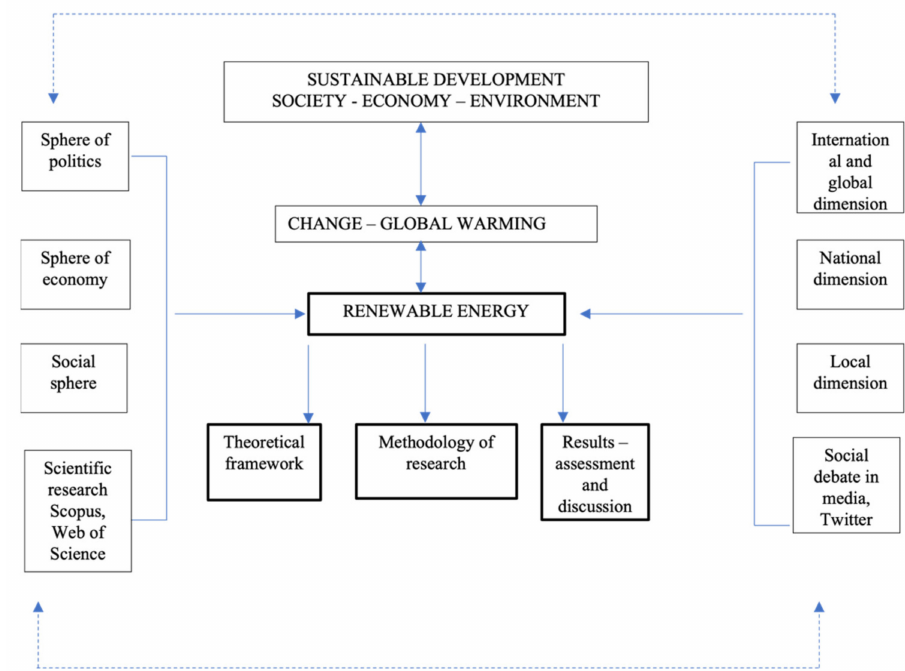
Figure 1. Morphology of the